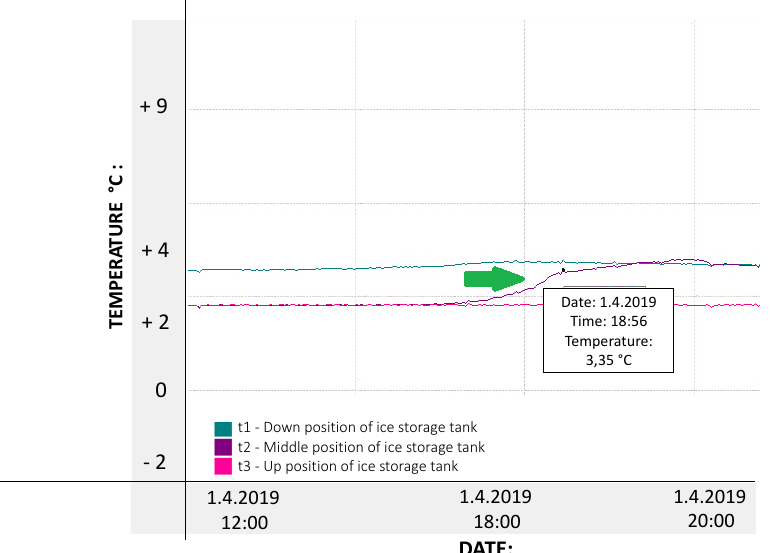
Figure 22. III. Phase—Melting ice t2.